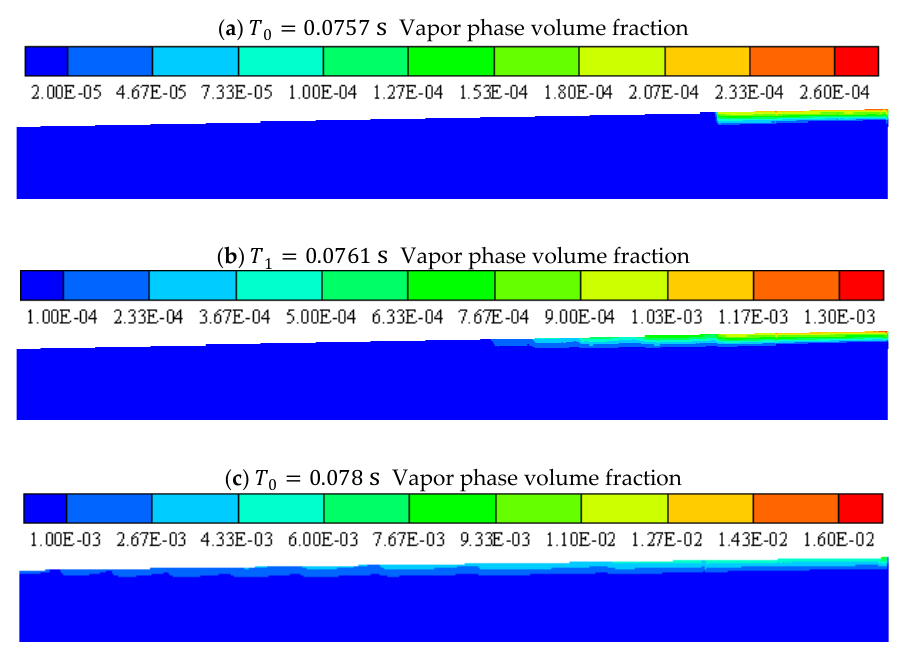
Figure 30. Evolution of vapor volume fraction on the axis plane of the pipeline in the cavity growth stage.